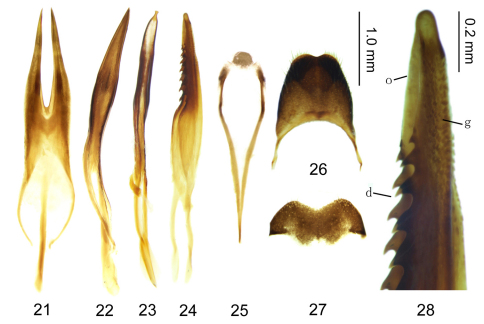
Male terminalia of Tillicera wenii sp. n., holotype 21–22 tegmen (21 dorsal view 22 lateral view) 23–24 phallus (23 ventral view 24 lateral view) 25 spicular fork 26 tergum VIII 27 sternum VIII 28 phallus, lateral view. Abbreviations: d = dorsal denticles f = file-like structures on phallic ventral membrane g = granular structures; o = median orifice.